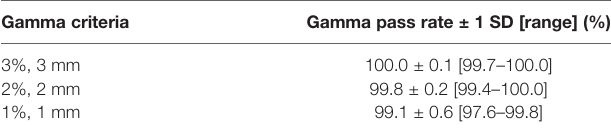
TABLE 4 | Global gamma evaluation, with a dose cut-off at 15%, comparing sCT and CT dose distributions, averaged over all patients. Gamma criteria Gamma pass rate ± 1 SD [range]